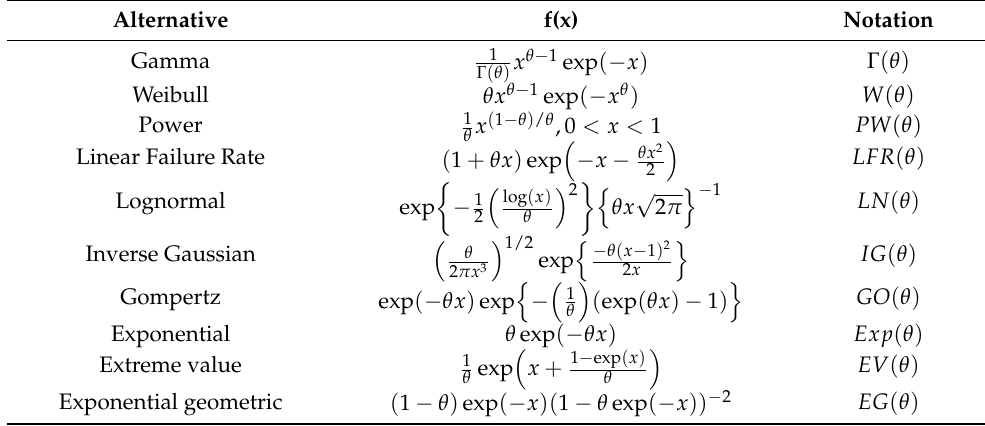
Table 1. Probability density functions of the alternative distributions considered in the Monte Carlo